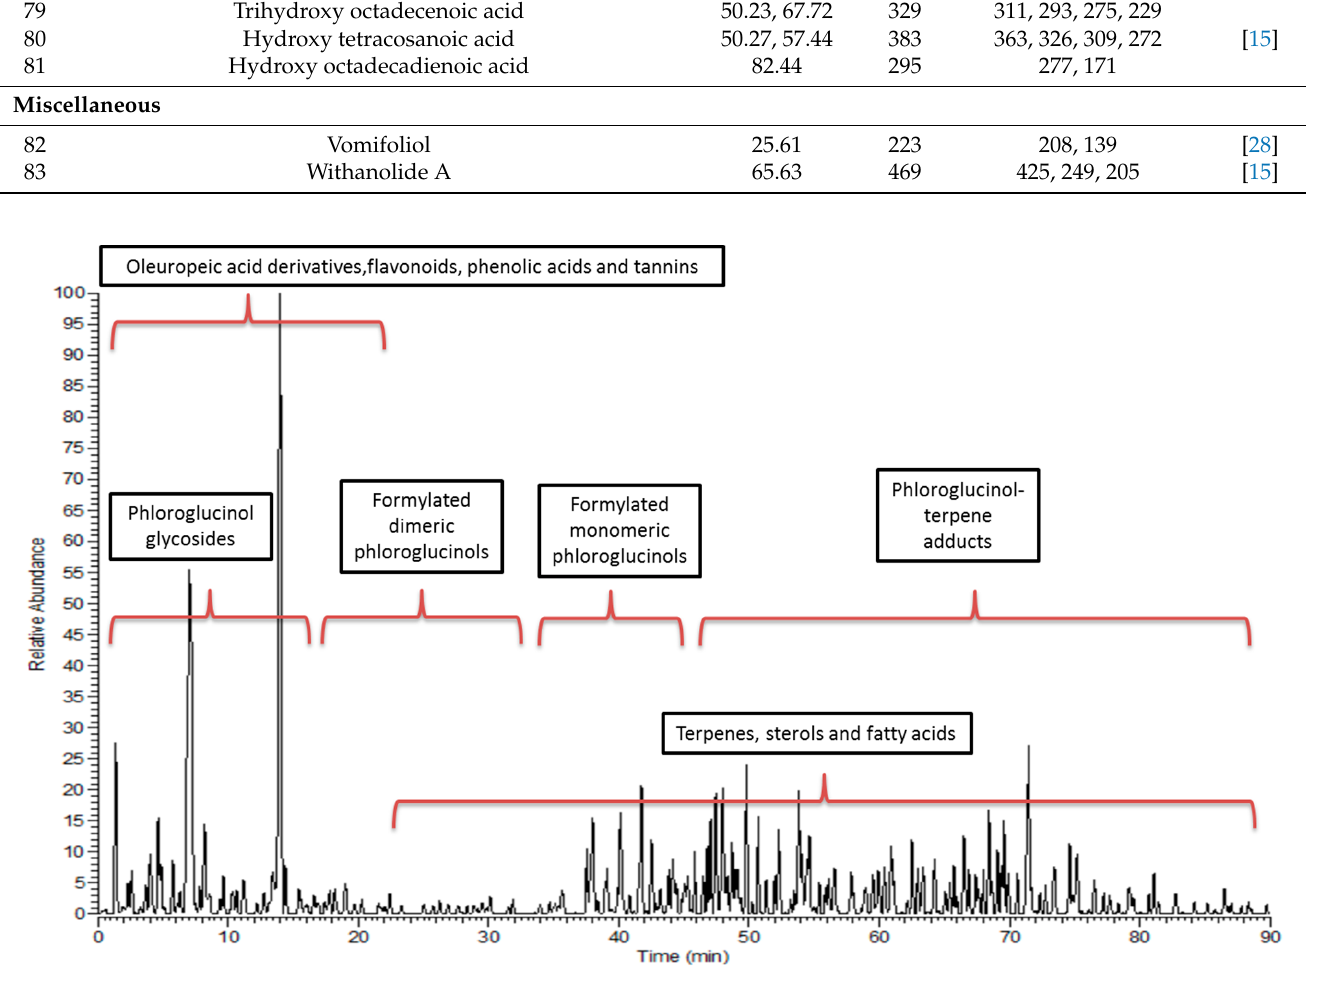
Eucalyptus , as well as the Plant Dictionary MS Database and